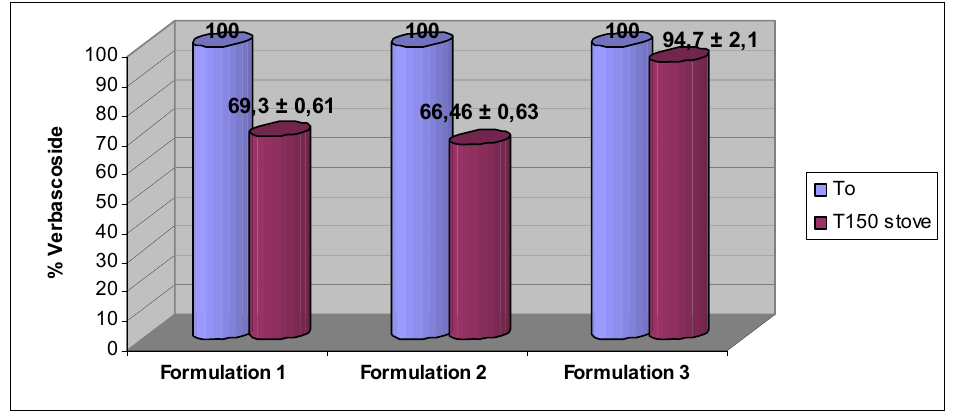
Figure 5. Verbascoside stability in the different formulations stored at 40 °C. Each value was obtained from three experiments (mean ± SE).